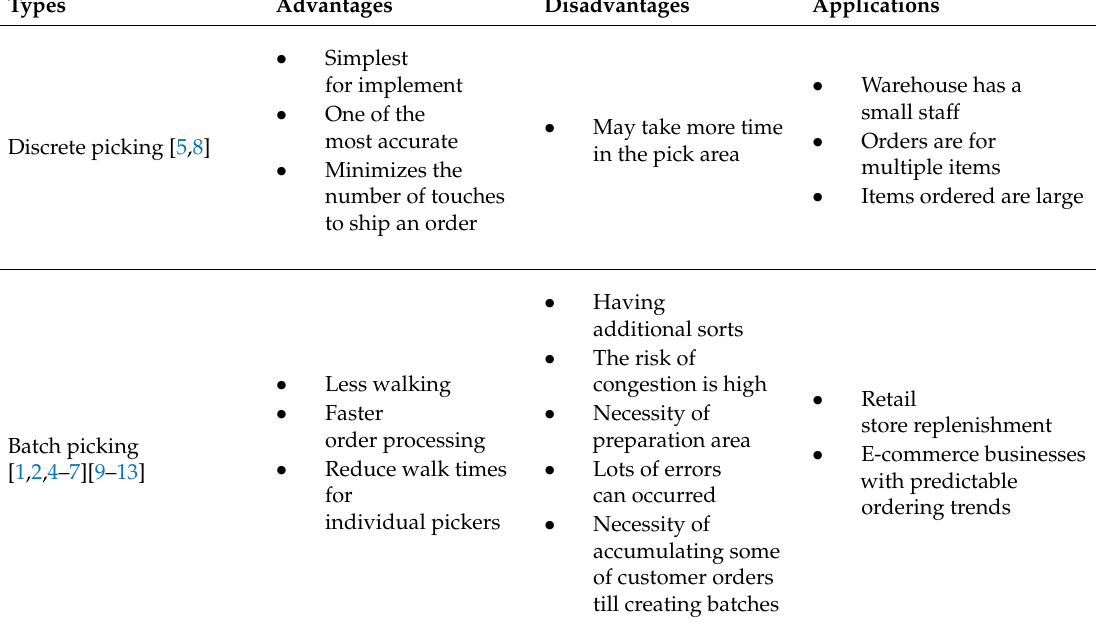
Table 1. Summaries of types of order picking policies or strategies.